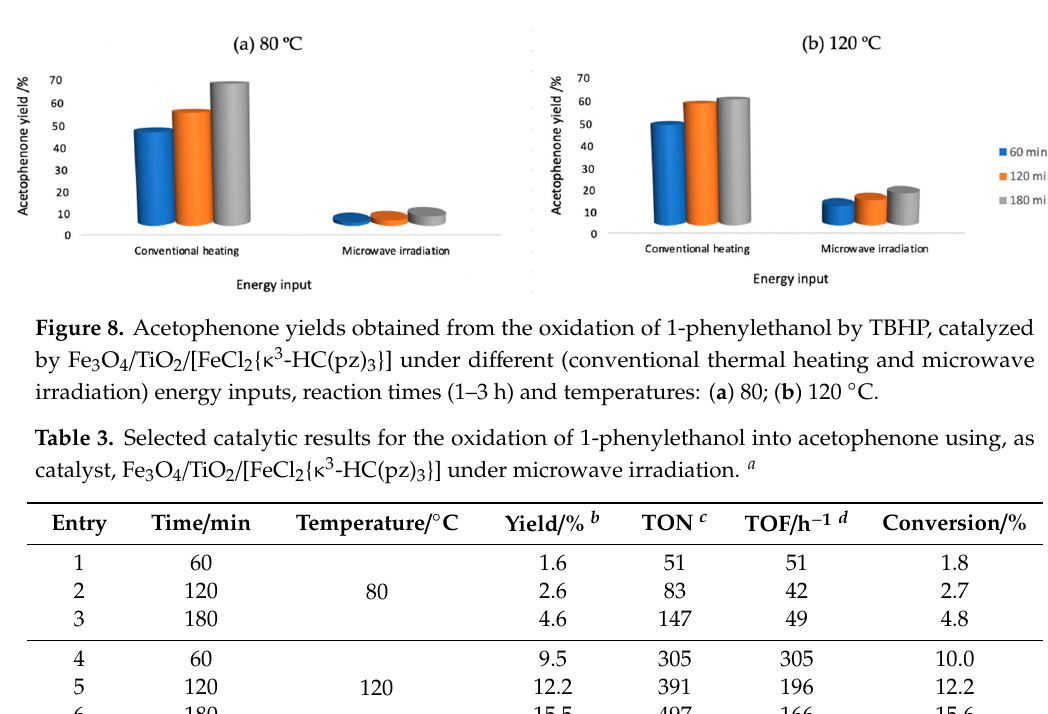
catalyst. d TOF (h − 1 ) = TON / reaction time.